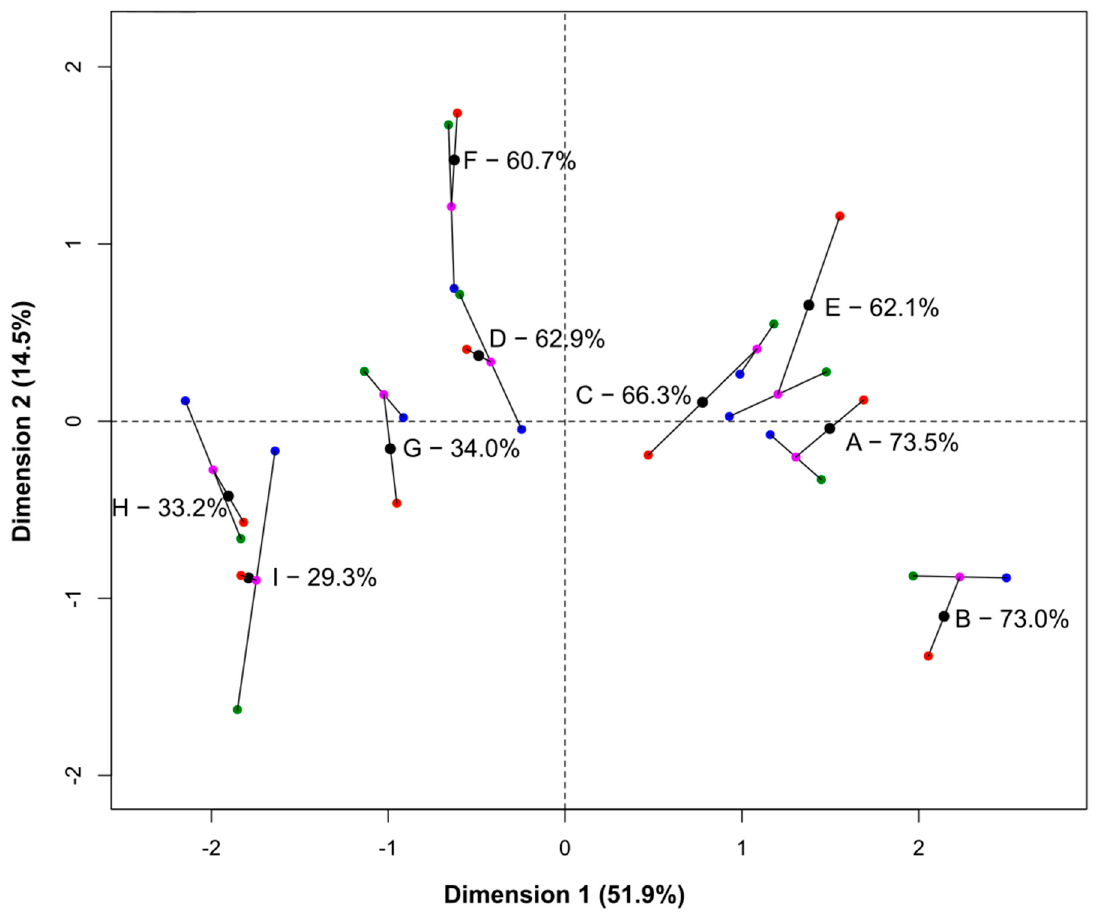
Figure 6. Superimposed presentation of the HMFA results of QDA, Napping and GC-MS data: Black points represent the mean point of a spirit. The coloured plots represent the different methods: green—QDA, blue—Napping, and red—GC-MS. The purple points represent the overall partial point of the sensory